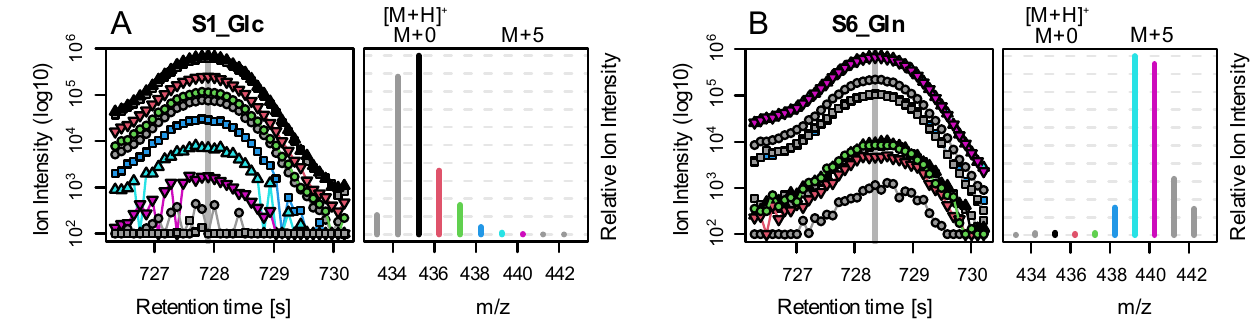
Figure 4. Base peak chromatogram (BPC, left ) and rawMID ( right ) for two example files from the biological data set. For both samples, we show the Gln peak: ( A ) after 24 h of Glc labelling and ( B ) after 24 h of Gln labelling. The rawMIDs are extracted from the respective BPC scan indicated by a vertical grey line. BPCs, and their corresponding rawMID relative intensities are color coded as follows: black indicates [M+H] + ; red, green, blue, light blue, and purple indicate [M+H] + +1 to 5; and grey indicates [M-H] + , [M] + , and [M+H]+6/7. Absolute intensities in BPCs are depicted in log10-scale, and rawMIDs are normalized relative to the highest ion peak in the MID. In sample S1 (Glc as tracer and Gln putatively non-labeled), we observe that the [M+H] + ion (black) shows the highest ion abundance. However, the rawMID represents an overlay of the MIDs of three adducts: [M-H] + , starting at m/z~433; [M] + , starting at m/z~434 (both grey); and [M+H] + , starting at m/z~435 (black). In consequence, the peak intensity at m/z~435 is actually the sum of three isotopes: [M-H] + +2, [M] + +1, and [M+H] + +0. In sample S6 (Gln as tracer and putatively fully labeled), we observe a clear shift in the MID by 5 mass units towards the right (caused by five 13 C labeled carbon atoms in Gln). However, to estimate the correct amount of labelling, we need to consider tracer impurity, natural abundance of Gln, as well as the C and Si atoms introduced by silylation and three relevant fragments (adducts).